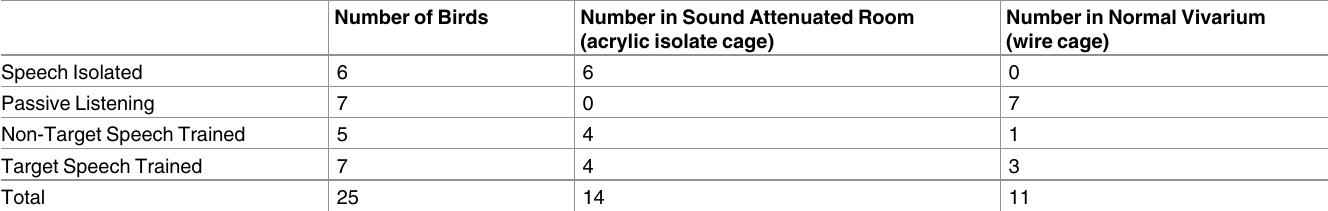
Table 1. Housing type (sound attenuated vs normal vivarium) for individual birds within each exposure